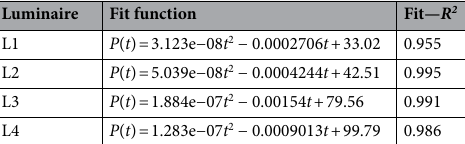
Table 4. Fit function of active